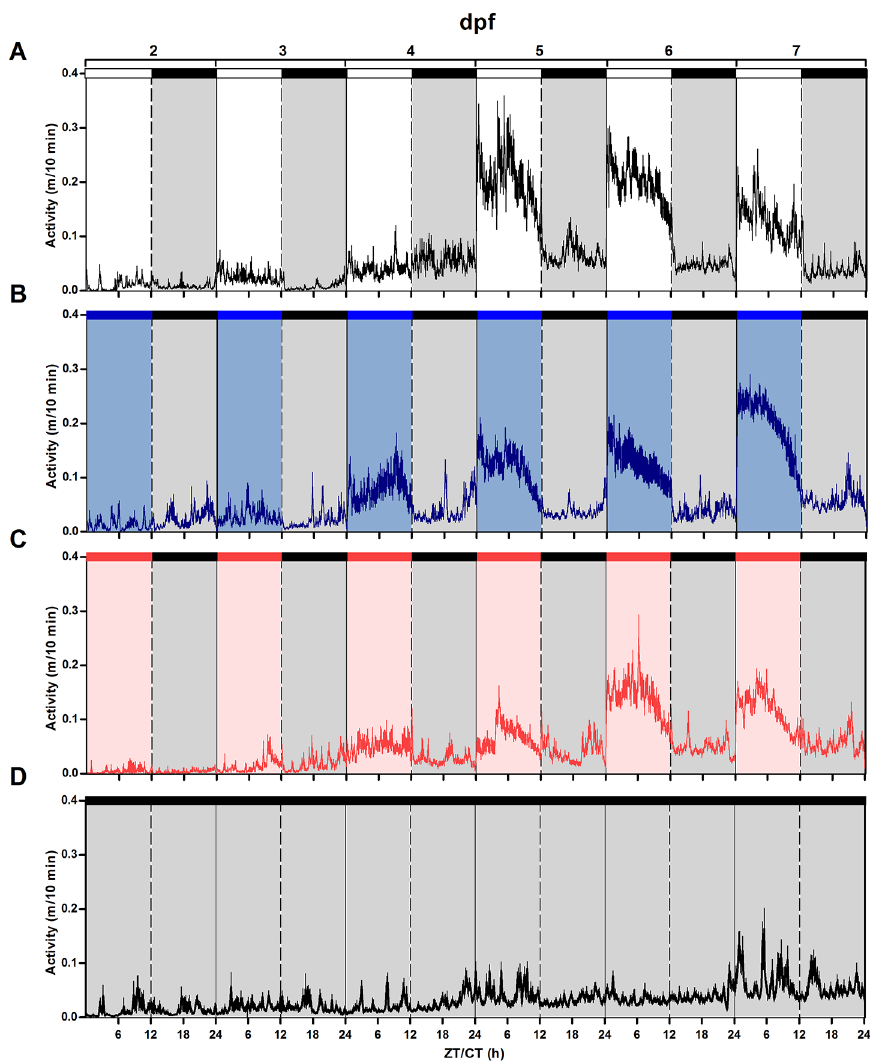
Fig 1. Mean waveforms of locomotor activity under different lighting conditions from 2 to 7 dpf. Larvae reared under different light conditions ( A : LDW, n = 35, B : LDB, n = 30, C : LDR, n = 30, D : DD, n = 45). Vertical axis represents activity (m/10 min) and horizontal axis zeitgeber/circadian time (ZT/CT). Bars above each panel indicate the lighting conditions [black bars indicate darkness, white bars indicate white light (LDW), blue bars indicate blue light (LDB), and red bars indicate red light (LDR)] and the day post-fertilization (dpf). Data are expressed as mean ± SEM.